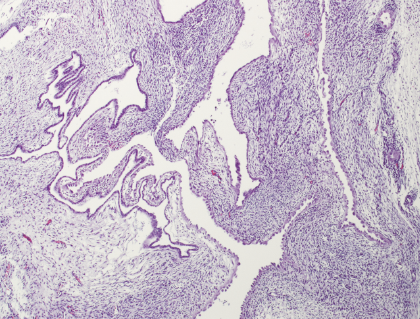
Figure 1: Axial, contrast-enhanced CT demonstrates a centrally located lobulated mass invading the renal vein and extending into the lumen of the inferior vena cava.